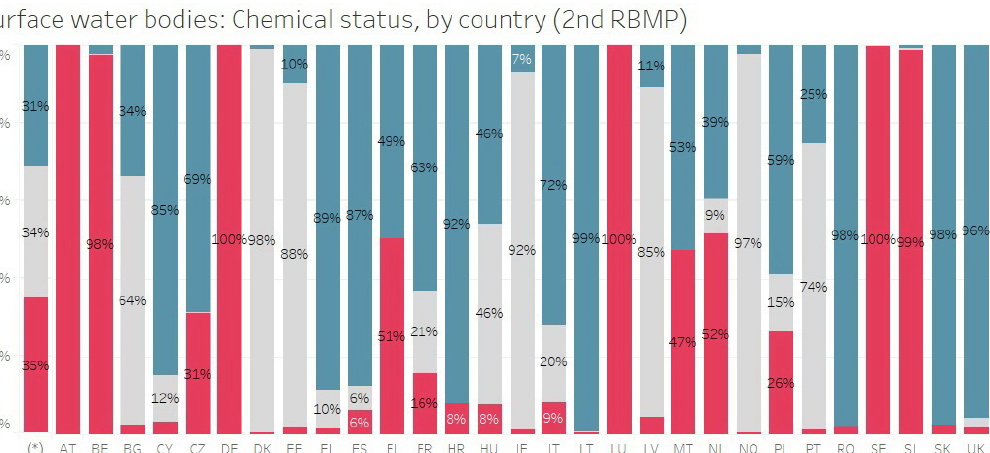
Figure 7. EU surface water bodies: chemical status by country (EU Water Framework Directive— Second River Basin Management Plan) [67]. Note: * column—all states.